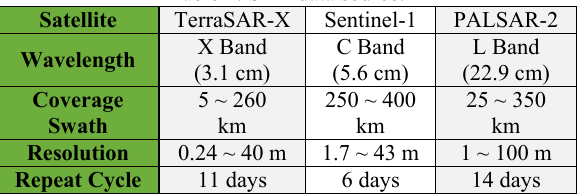
Table 1. SAR data